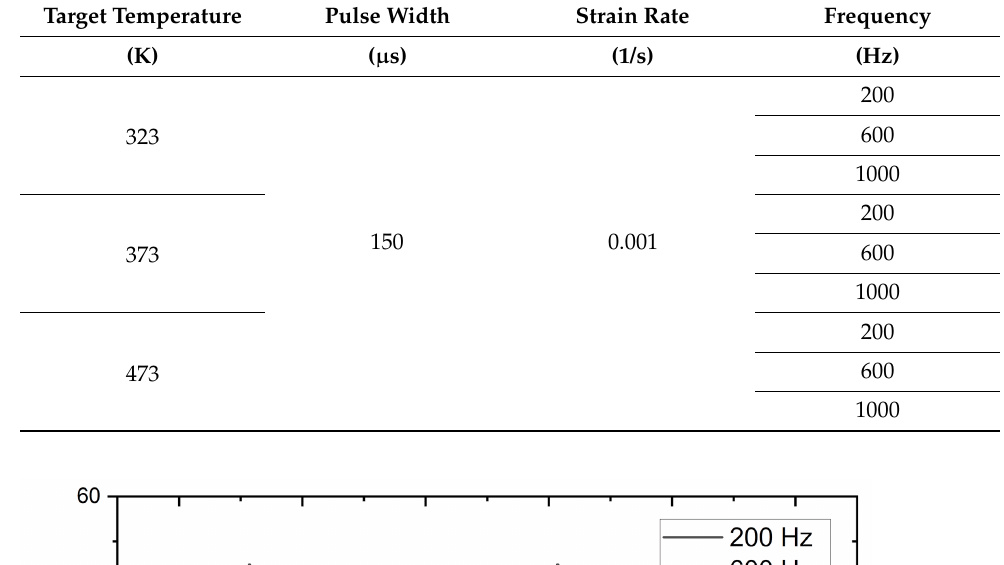
Table 2. Experimental parameters.